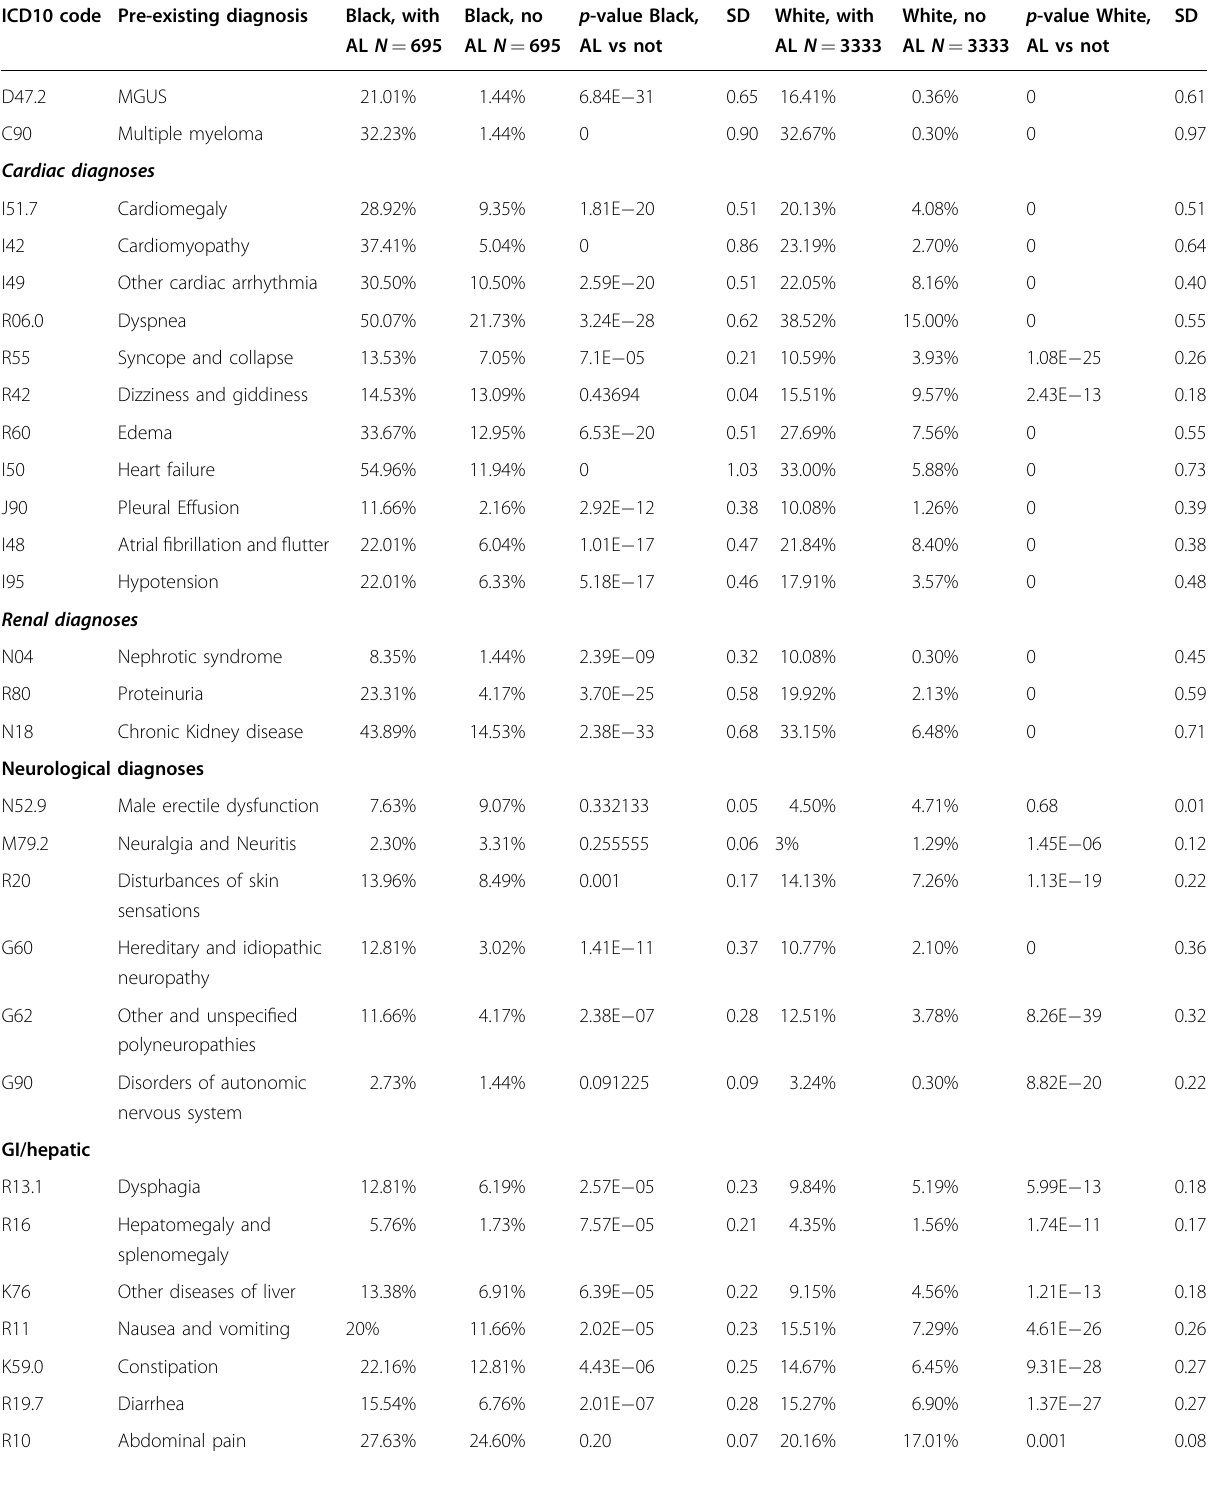
Table 2 Comparison between pre-existing diagnoses in individuals with or without AL amyloidosis strati fi ed by